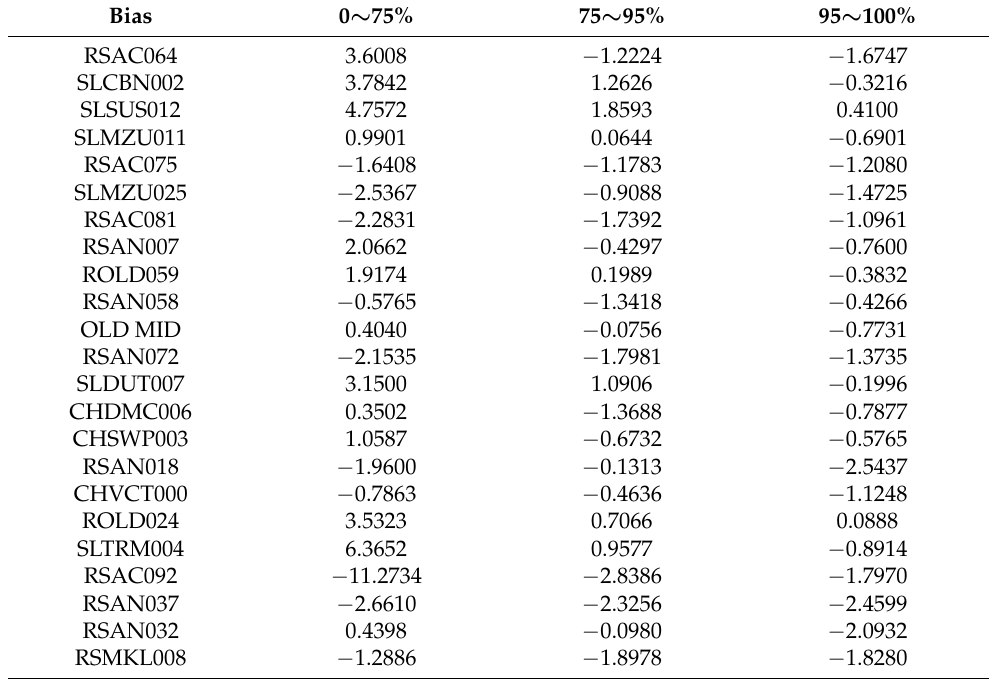
Table A7. Station-wise percent bias results of Res-LSTM at daily time step.